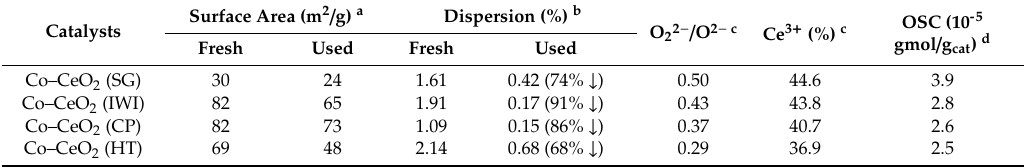
Table 1. Characteristics of Co–CeO 2 catalysts prepared by di ff erent synthetic methods.